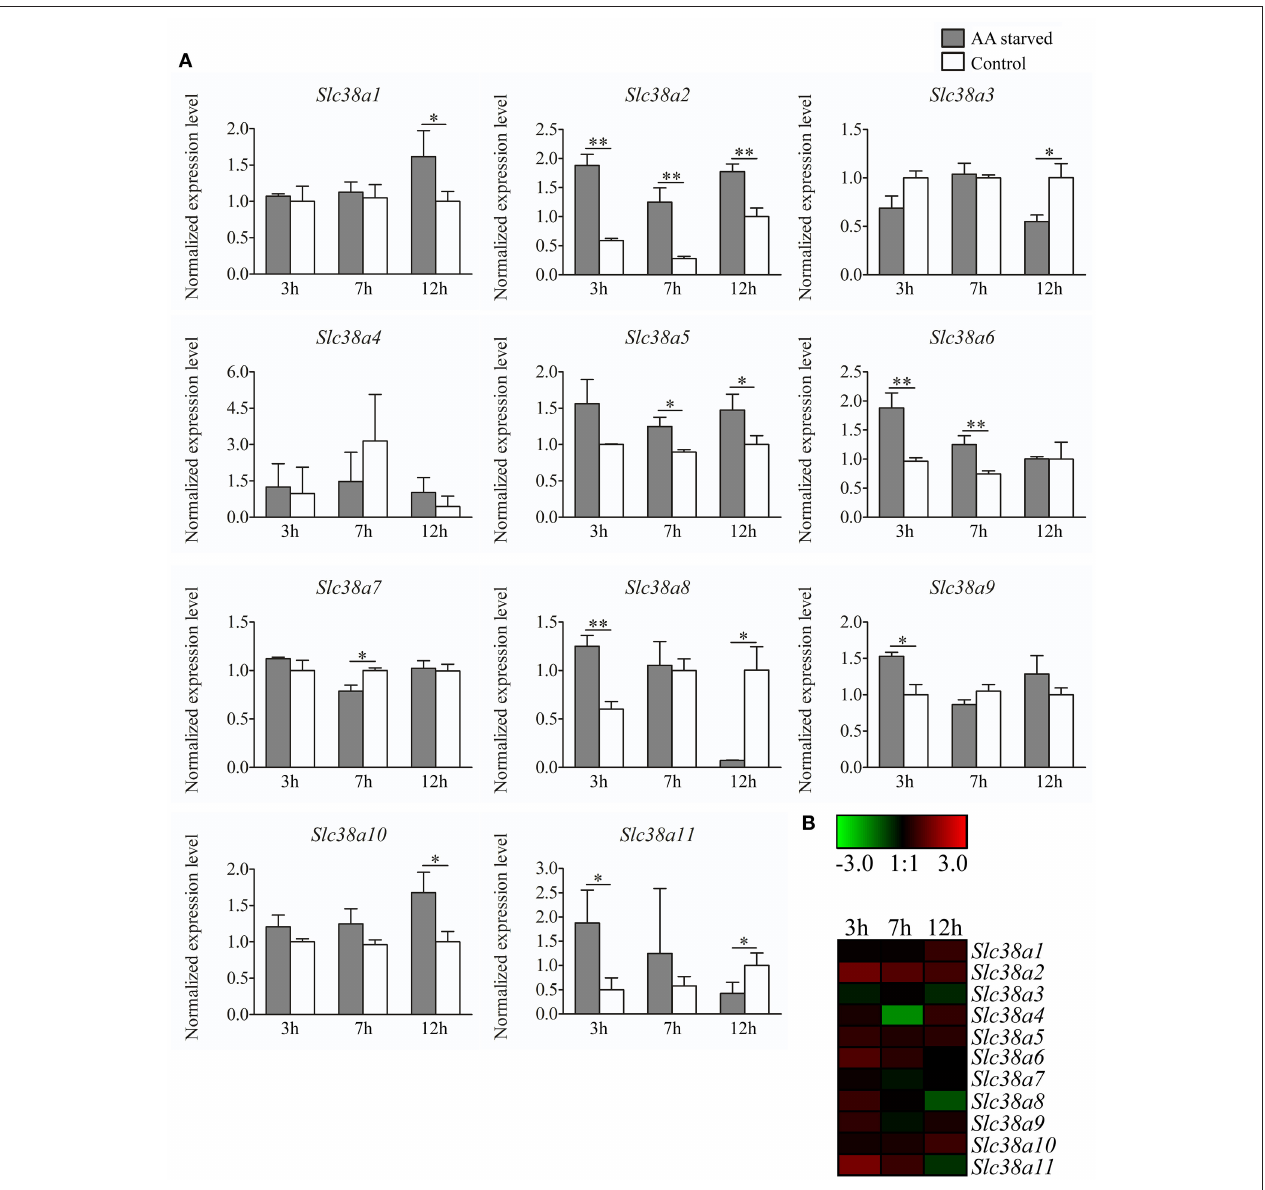
FIGURE 4 | Gene expression analysis of Slc38a1-11 in primary cortex cells at 3h, 7h and 12h treatment. (A) Gene expression data from the primary cortex cells using qPCR for Slc38a1-11 . The gene expression levels were normalized against m β -Actin , mGlycerylaldehyde 3-phosphate dehydrogenase, and mHistone 3a and the normalized expression level ± SD ( n = 3) is presented for each gene. Dark gray bars represent amino acid starved cells and white bars represent amino acid treated controls. Unpaired t-tests were used between starved cells and controls (* ≤ 0.05, ** ≤ 0.01) to analyze alteration in gene expression. The x-axis represents time of treatment in hours and the y-axis represents the normalized mRNA expression levels. (B) Heat map analysis summarizing the gene expression alterations measured with qPCR for Slc38a1-11 . The color scale represents the difference between the mean value of normalized expression in starved and control cells. Green color represents downregulation and red color represent upregulation of gene